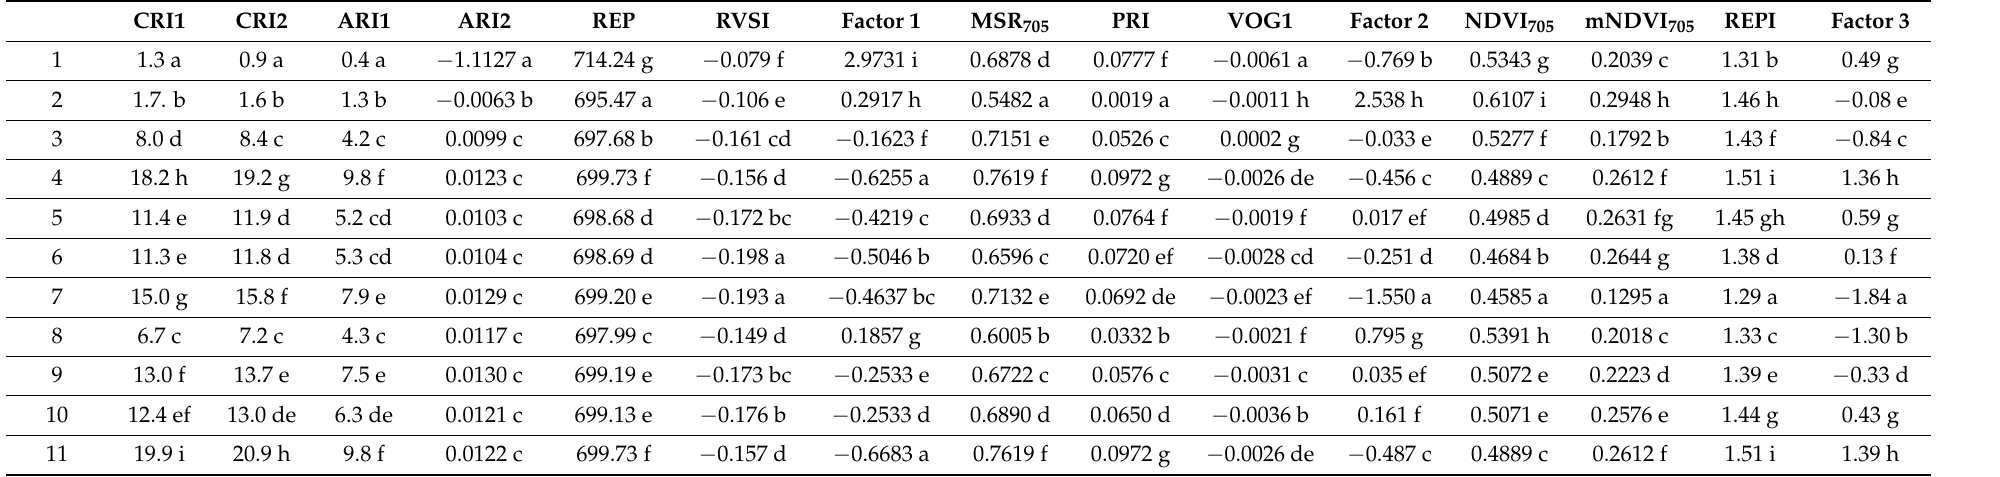
Table 5. Results of a posteriori comparison of variable index values (according to Duncan’s